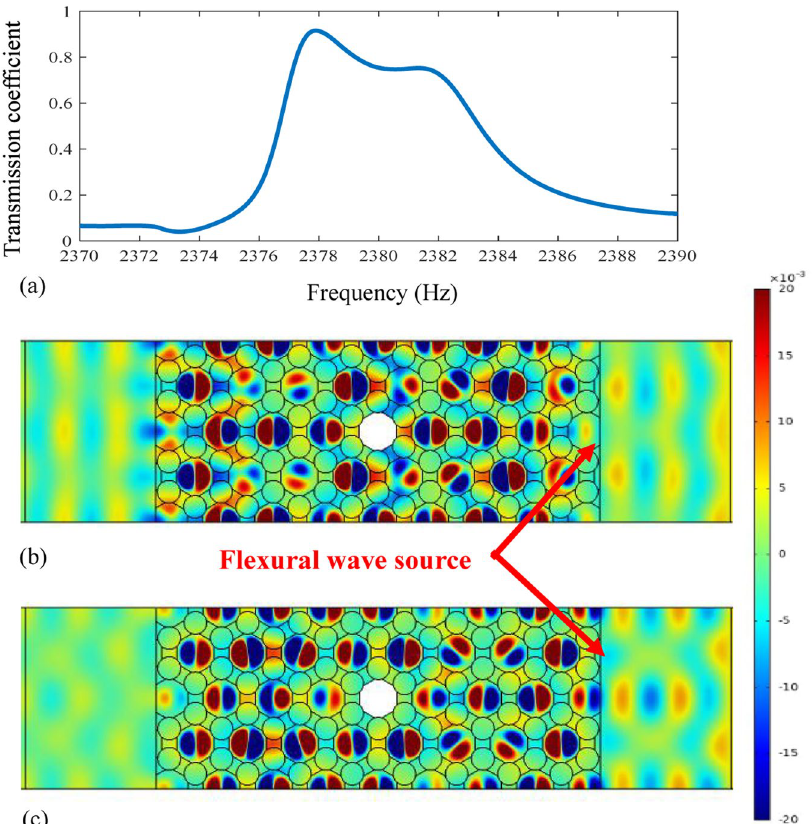
Figure 3. ( a ) Transmission coefficient, ( b ) wave propagation at 2377.9Hz with electrical circuits and ( c ) wave propagation without electrical circuits at 2377.9 Hz.